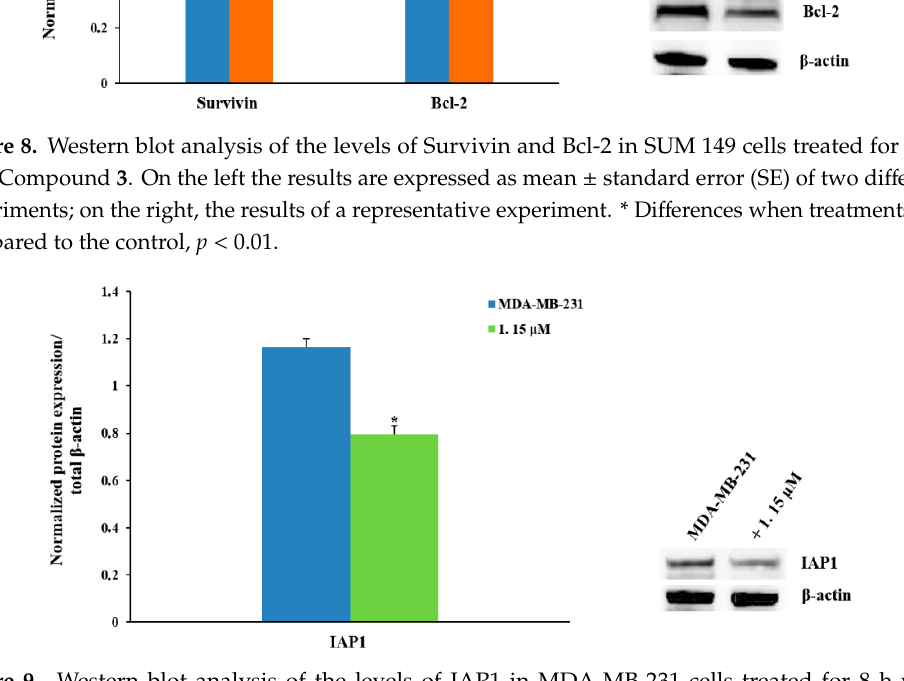
Figure 9. Western blot analysis of the levels of IAP1 in MDA-MB-231 cells treated for 8 h with Compound 1 . On the left are the results expressed as mean ± standard error (SE) of two different experiments; on the right, the results of a representative experiment. * Differences when treatments are compared to the control, p < 0.01.